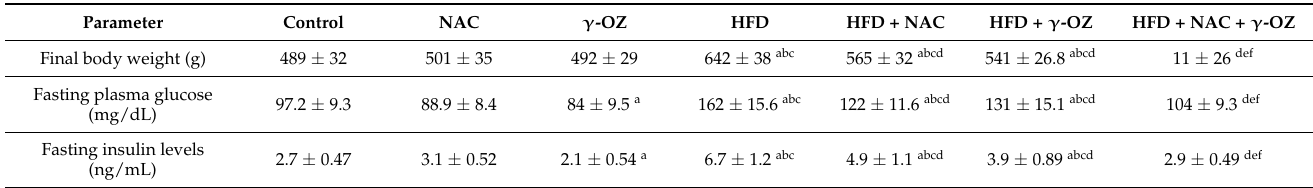
Figure 2. The average weights of various fats in all groups of rats. ( A ): average changes in mesenteric fats; ( B ): average changes in subcutaneous fat; ( C ): average changes in peritoneal fat; and ( D ): average changes in epididymal fat in all groups of rats. Data are presented as means ± SD (n = 8/group). The value of significance was determined at p < 0.05. a: significantly different as compared to the control group; b: significantly different as compared to the NAC-treated control rats; c: significantly different as compared to the γ -Oryzanol-treated rats; and d: significantly different as compared to the HFD-fed group; e: significantly different as compared to the HFD + NAC-treated rats; and f: significantly different as compared to the HFD + γ -oryzanol-treated rats. Table 1. γ -Oryzanol (OZ) and N-acetylcysteine (NAC and their combination attenuate the increase in body weights, hyperglycemia, hyperinsulinemia, and the alterations in circulatory adipokines in high-fat-diet (HFD)-fed